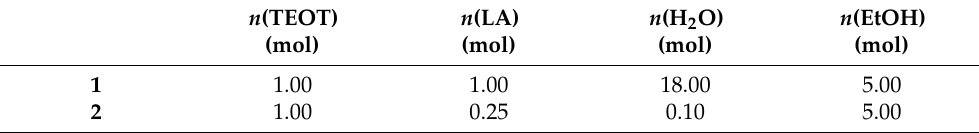
Table 1. Overview of the sol compositions for the spinning of 1 and 2